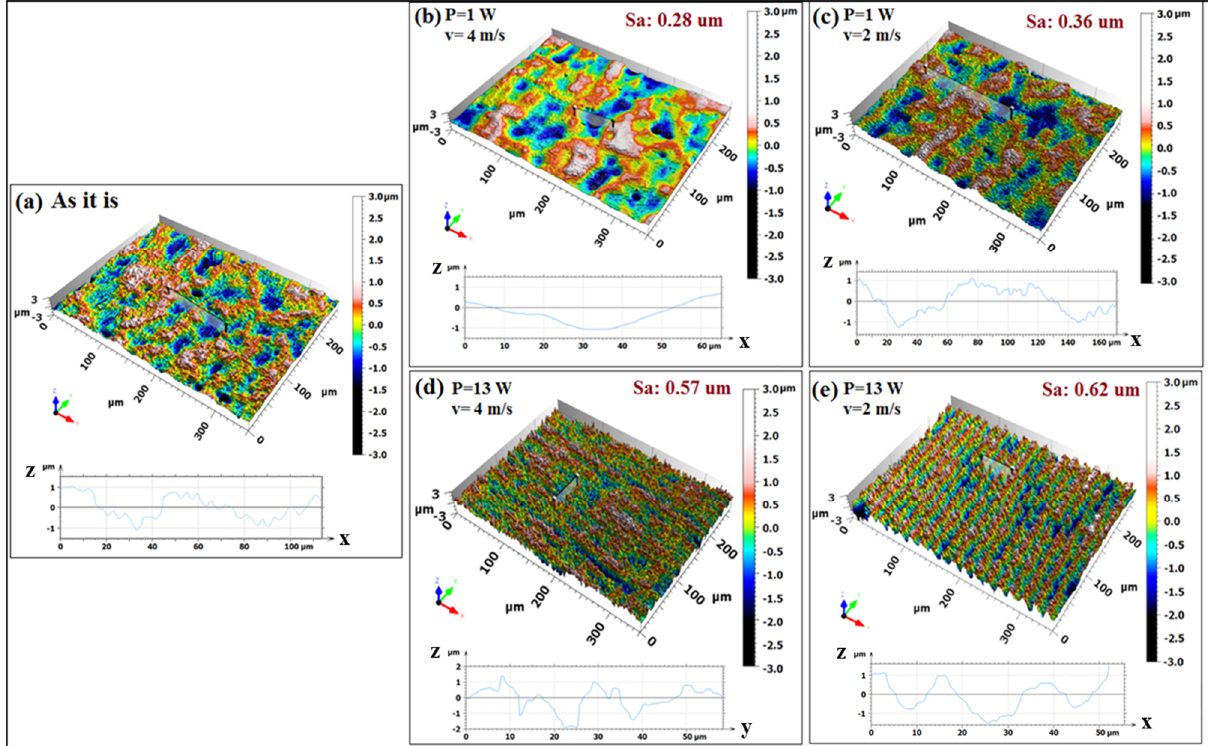
Figure 2. Three-Dimension-profilometry and 2D profile of as it is sample ( a ); P = 1 W, v = 4 m/s ( b ); P = 1 W, v = 2 m/s ( c ); P = 13 W, v = 4 m/s ( d ) and P =13 W, v =2 m/s ( e